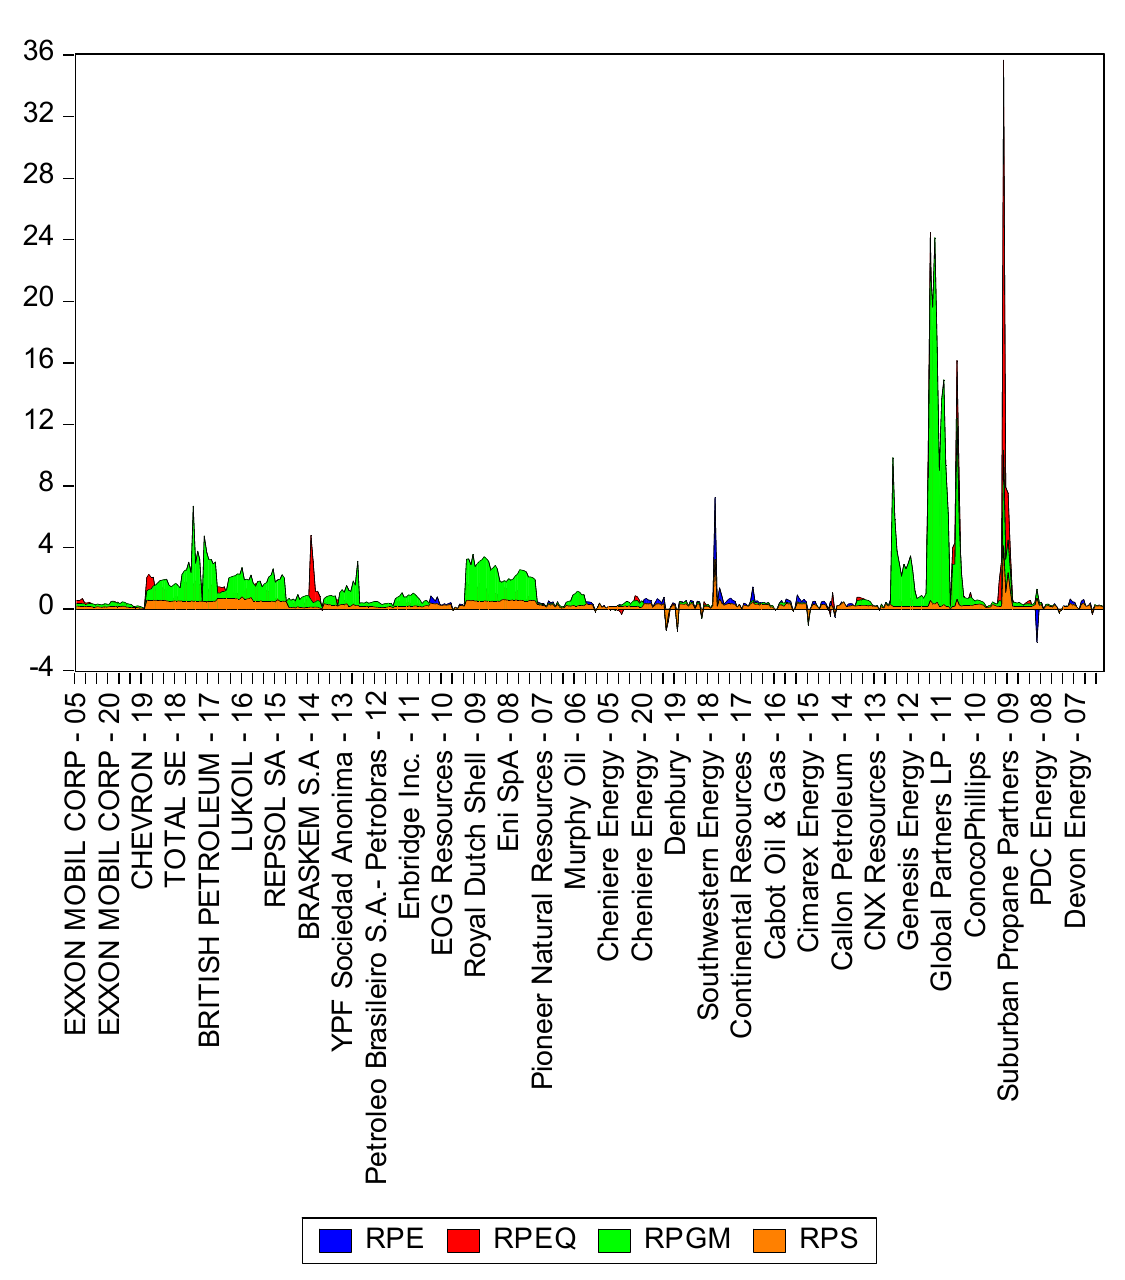
Figure 7. Evolution of fiscal pressure indicators for oil companies.